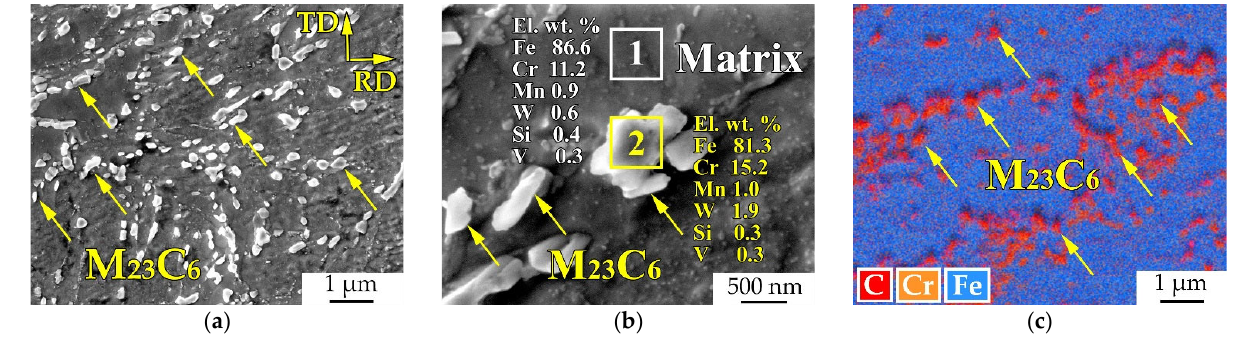
Figure 5. M 23 C 6 carbides in EK ‐ 181 steel after HTMT: SEM SE images ( a , b ), EDX elemental map ( c ). After THT, the average size of such particles is ≈ 250 nm (Figure 4). Their volume fraction, estimated from the area they occupy in SEM images, reaches ≈